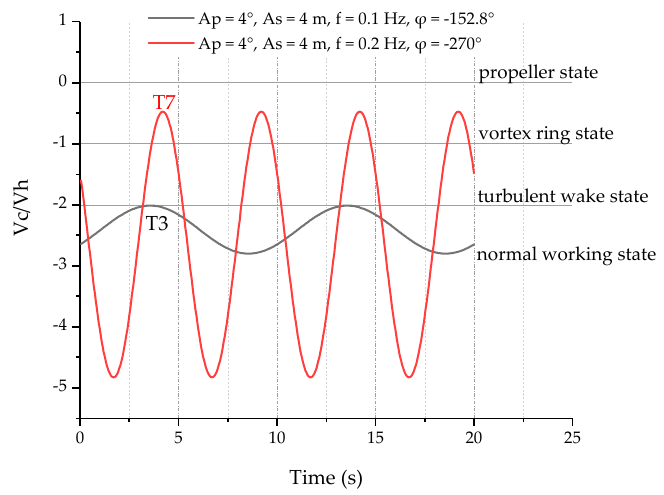
Figure 20. VRS identification scheme under combined motion with phase difference. Figure 21a,b display the iso-surface of the vortex at T3 moment under case 20. The